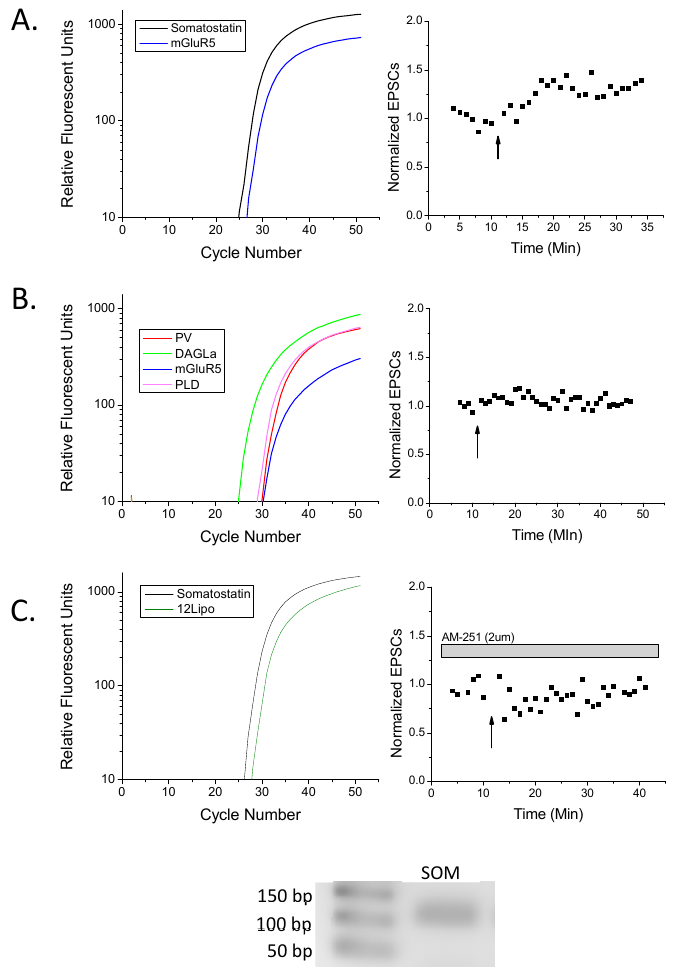
Figure 2. Real-time (RT)-PCR confirms somatostatin-positive (SOM+) rat hippocampal cells exhibit LTP. A . An example SOM+ cell from Figure 1A that expressed type I metabotropic glutamate receptor 5 (mGluR5), and exhibited HFS-LTP. B . An example parvalbumin-positive (PV+; somatostatin-negative) cell from Figure 1A that expressed diacylglycerol lipase (DAGL α ), mGluR5, and n-acylphosphatidylethanolamine phospholipase D (NAPE-PLD, abbreviated PLD) that did not